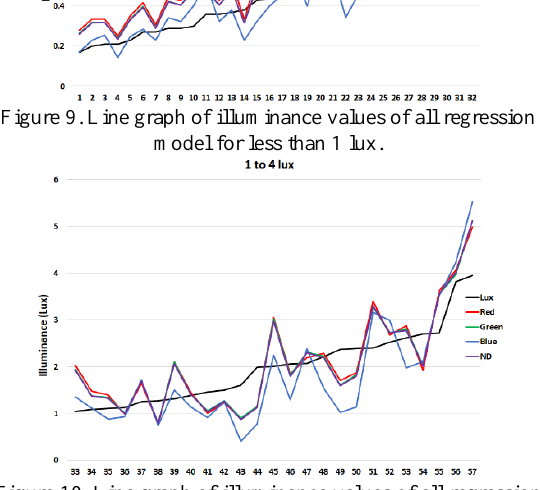
Figure 9. Line graph of illuminance values of all regression model for less than 1 lux.